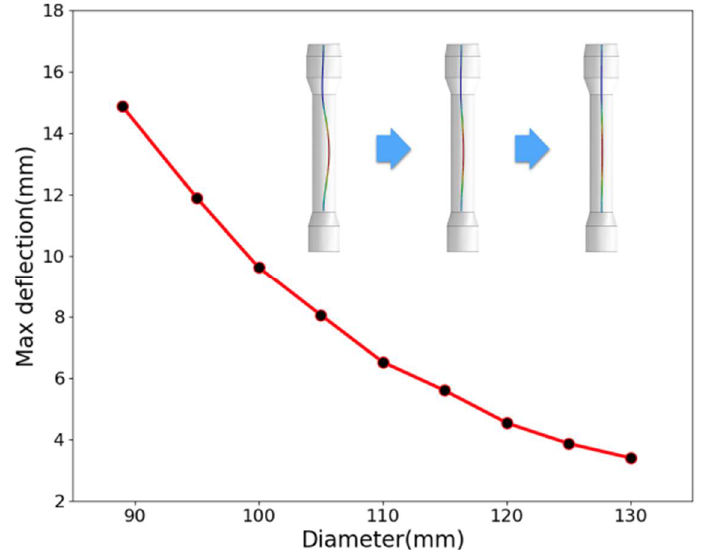
Figure 11. Maximum deflection versus the diameter of the main shaft.